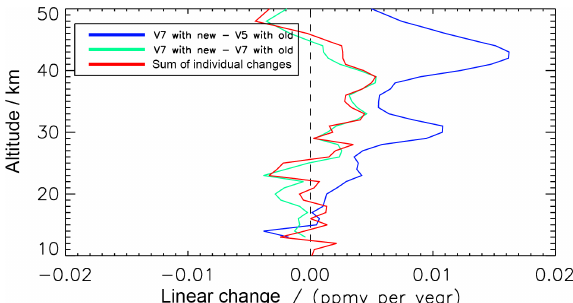
Figure 3. Sensitivity of the linear change in ozone to the changes in retrieval setup and Level 1B spectra. Versions 5 and 7 refer to the versions of Level 1B MIPAS spectra on which the retrieval is run. “Old” and “new” refer to the old and new retrieval setups. The blue line shows the linear change in ozone when both the retrieval setup and the version of the Level 1B spectra are changed. The green line illustrates the linear change in ozone when only the retrieval setup is changed and is applied in both cases to the same version 7 Level 1B spectra. The red line shows the linear change in ozone originating from the sum of individual changes in the retrieval, shown in Fig. 2, applied to the same version of Level 1B